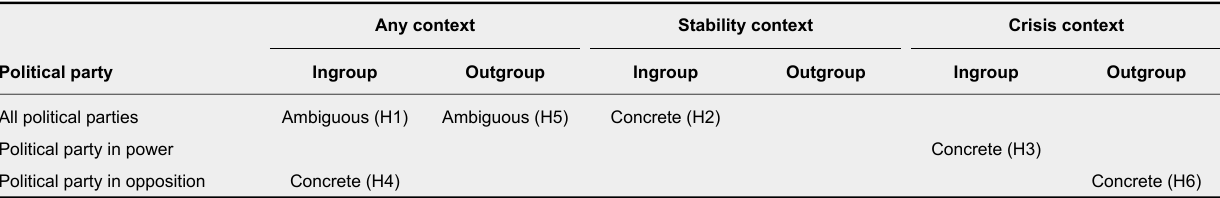
Expected Ingroup and Outgroup Forms per